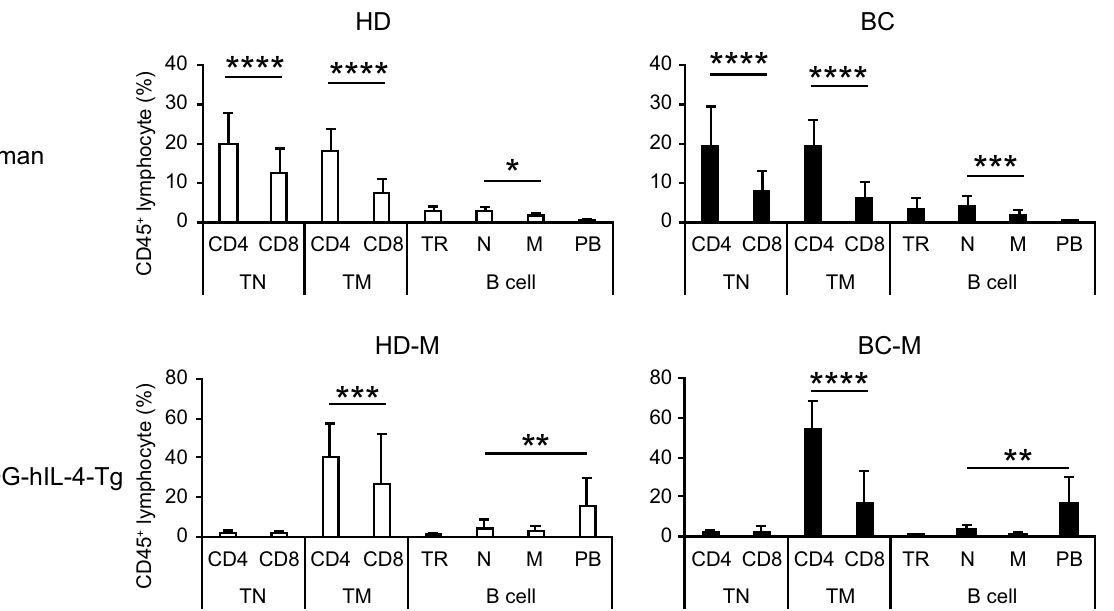
Figure 1. The hu-PBL hIL-4 NOG mice reflected HD/BC T cell and B cell phenotypes. Proportions of CD4 and CD8 T cells in human PBMCs and PBMC-transplanted NOG-hIL-4-Tg in human CD45-gated fractions were compared. (A) Healthy donor (HD) (open bar: n = 39) and breast cancer patient (BC) (black bar: n = 47) PBMCs. (B) NOG-hIL-4-Tg spleens transplanted with HD (filled bar: n = 26) or BC (white bar: n = 11) PBMCs. Data are expressed as mean ± Standard Deviation of each cell subset. * p = 0.05, ** p = 0.01, *** p = 0.001, **** p = 0.0001. CD4 TN Naïve CD4 + T cell, CD8 TN Naïve CD8 + T cell, CD4 TM Memory CD4 + T cell, CD8 TM memory CD8 + T cell, TR transitional, N naïve, M memory, P plasmablast; BC breast cancer; HD healthy donor; PBMCs peripheral blood mononuclear